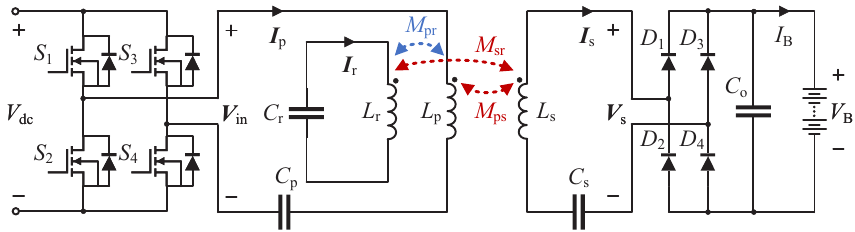
Figure 1. Circuit configuration of the S-S-S-compensated WPT system with cooperative